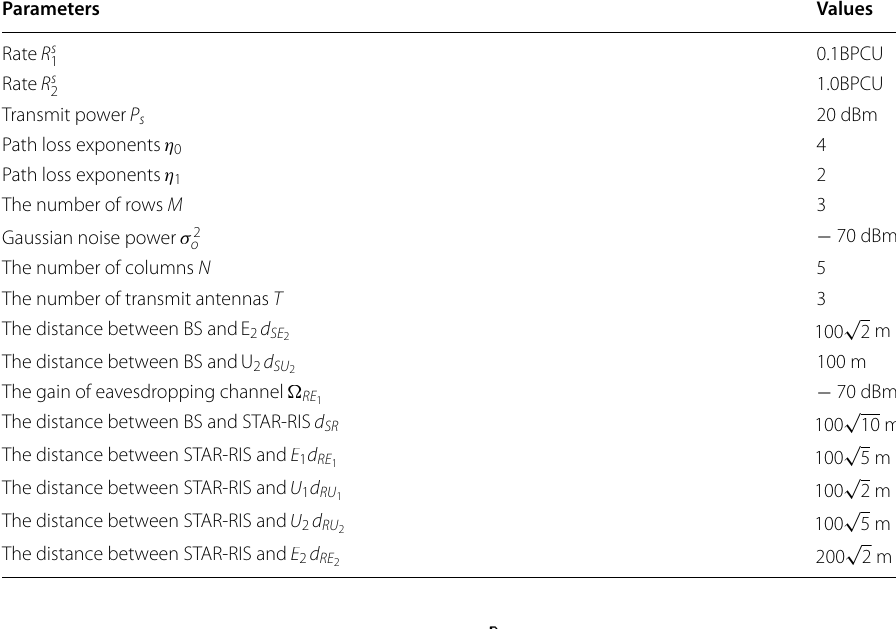
Table 1 Simulation parameters